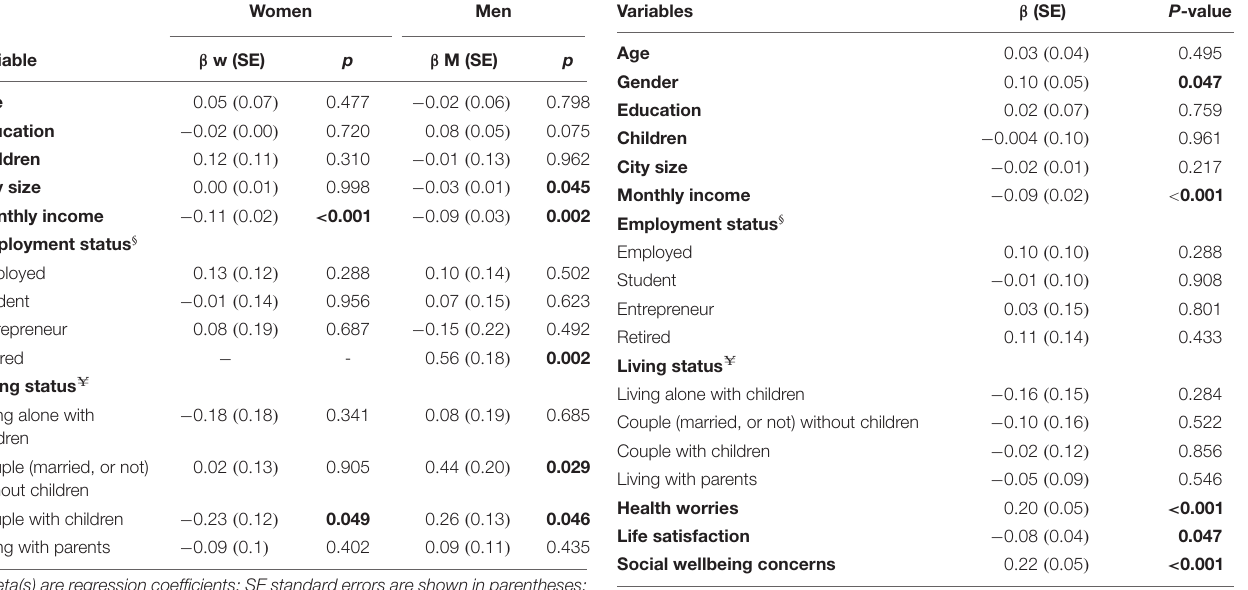
TABLE 4 | Regression analysis to explain relationships between personal economic worries and mental wellbeing factors accounting for demographics.